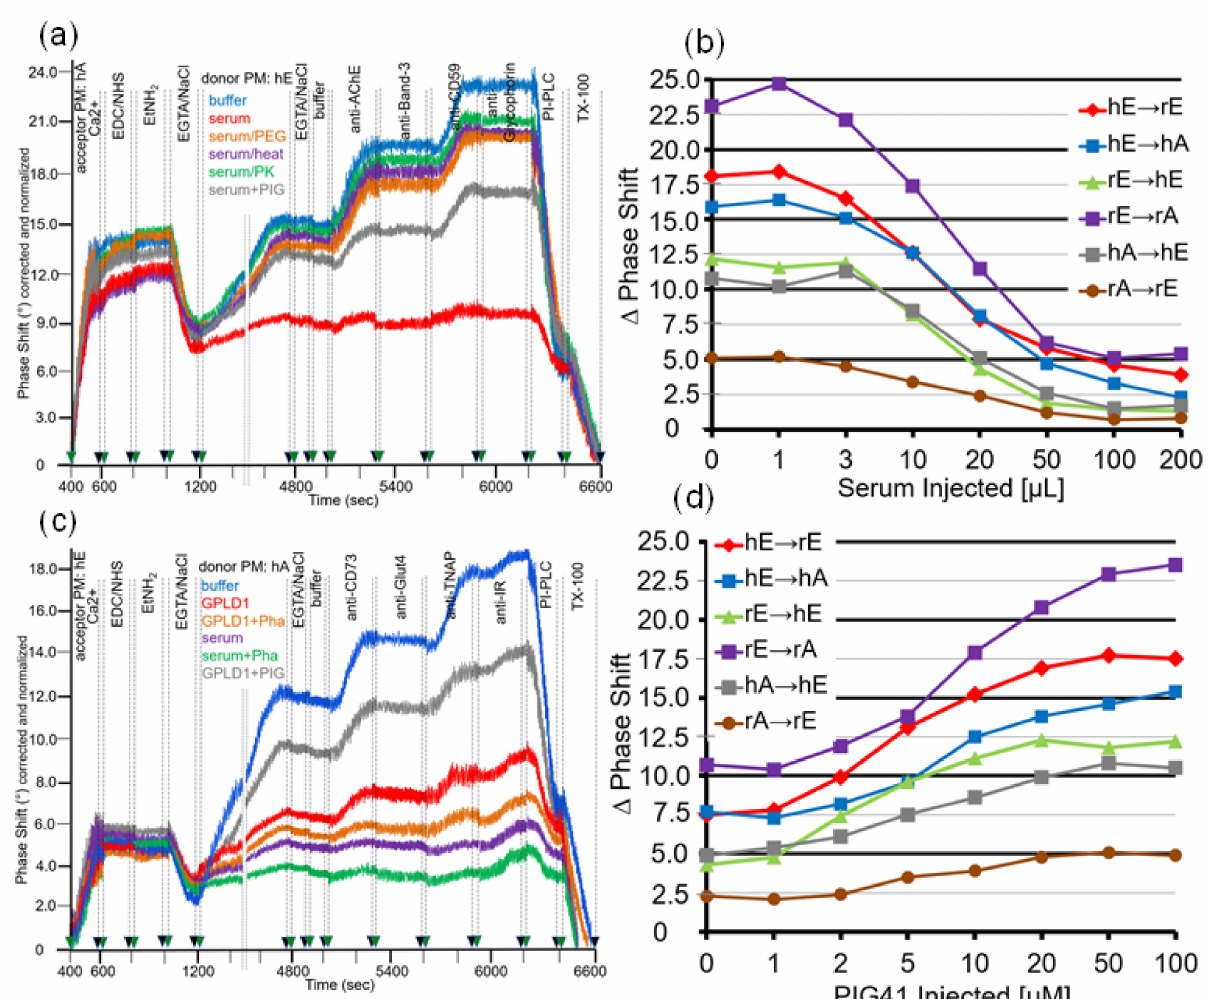
Figure 8. Effect of serum proteins and PIG on the transfer of full-length GPI-APs from donor to acceptor PM at various combinations. 400 µ L of human erythrocyte ( a ) or adipocyte ( c ) donor PM were injected at 1200 s and at a flow rate of 60 µ L/min into chips with human adipocyte ( a ) and erythrocyte ( c ), respectively, acceptor PM captured by ionic (Ca 2+ ) and covalent bonds (EDC/NHS). ( a , c ) After blockade with EtNH 2 and washing with EGTA/NaCl as described for Figure 2, 100 µ L of washing buffer or serum from obese rats (diluted 5-fold with buffer), which had been treated with PEG6000, heat, proteinase K (PK), or supplemented with GPLD1 (0.4 units) alone or together with 30 µ M PIG41 or 100 µ M Pha, were injected as indicated. Thereafter, the chips were incubated until 4800 s at 37 ◦ C at flow rate 0 (double hatched lines). Following injection of EGTA/NaCl and then washing buffer, the protein composition of the acceptor PM was assayed by consecutive injection of antibodies against GPI-APs and transmembrane proteins, then of PI-PLC, and finally of TX-100 as indicated. The phase shift measured is given upon correction for unspecific interaction (no acceptor PM) and normalization for variable capturing efficacy. The experiment was repeated once with similar results. ( b ) Increasing volumes of rat serum (diluted 5-fold) or buffer or ( d ) 20 µ L of rat serum, together with increasing concentrations of PIG41 or buffer, were injected. ∆ phase shifts as measure for GPI-AP transfer are calculated as described for Figure 3. The experiments were repeated two times with similar results. Mean values are given for each donor–acceptor PM